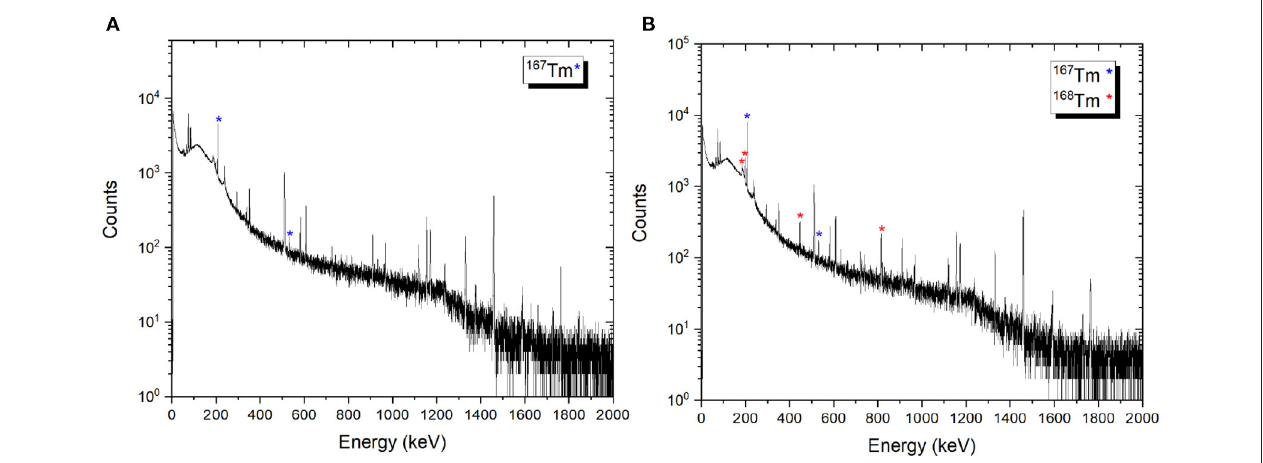
FIGURE 10 | Examples of gamma spectra of the 167 Tm implanted foils 2A (A) and 3C (B) . The measurements were performed 3 months after mass separation, using the same sample detector distance and counting time.